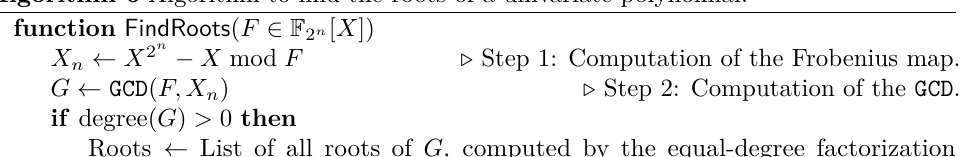
Algorithm 6 Algorithm to find the roots of a univariate polynomial. function FindRoots ( F ∈ F 2 n [ X